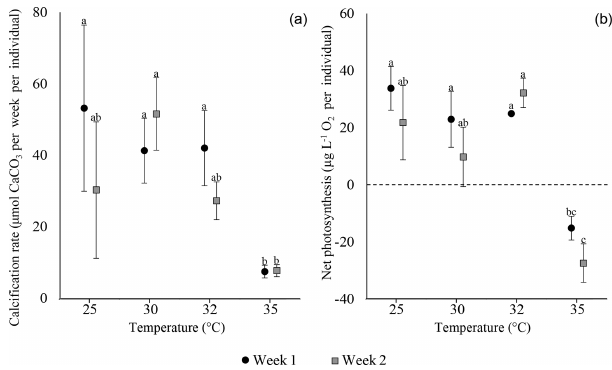
Figure 4. Calcification rates (a) and net photosynthesis (b) of A. lobifera . Note the synchronous negative response at 35 ◦ C. Error bars are SE, and letters represent the results of the post hoc tests between temperatures and weeks (Tables S5.2 and